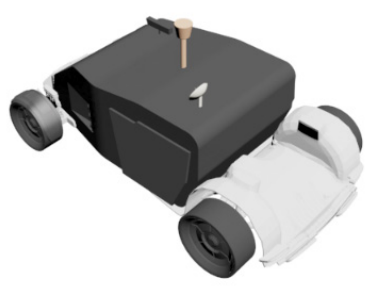
Figure 5. Simulation model of the lunar rover.